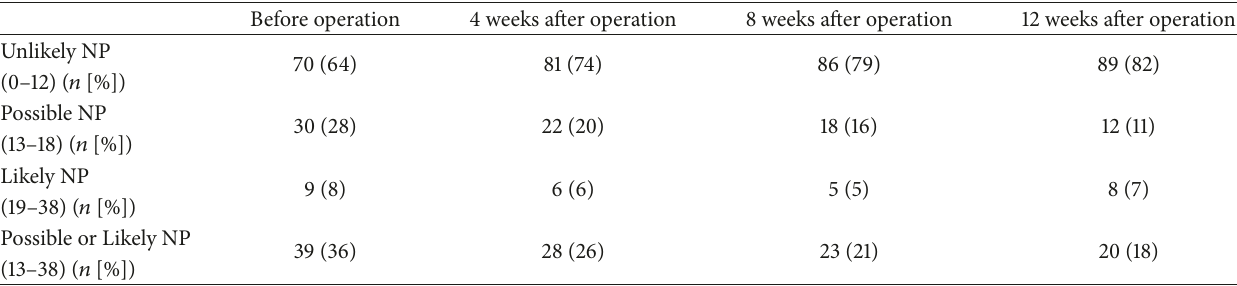
Table 3: Changes in the painDETECT